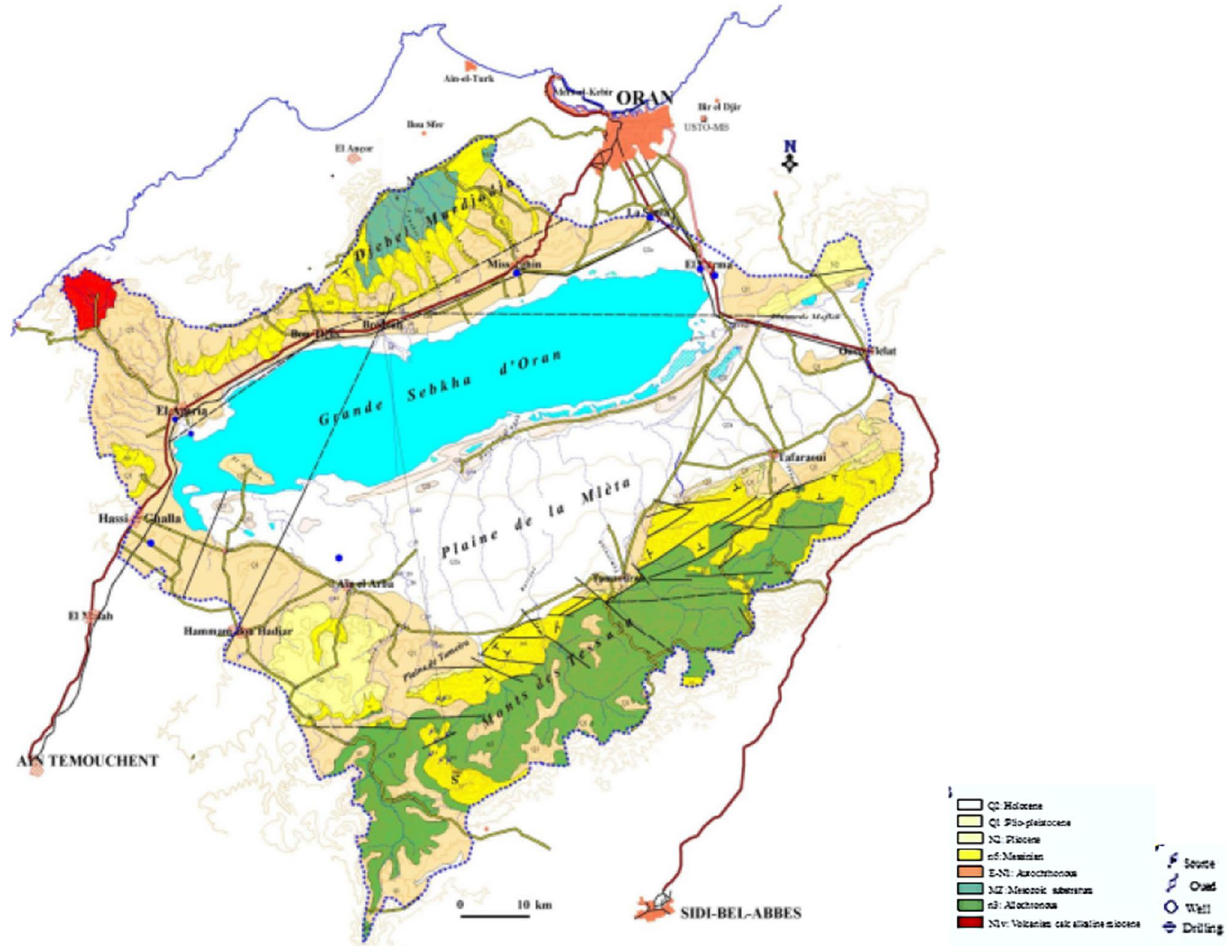
Fig. 1 Geological map of Oran Sebkha Basin (Benziane